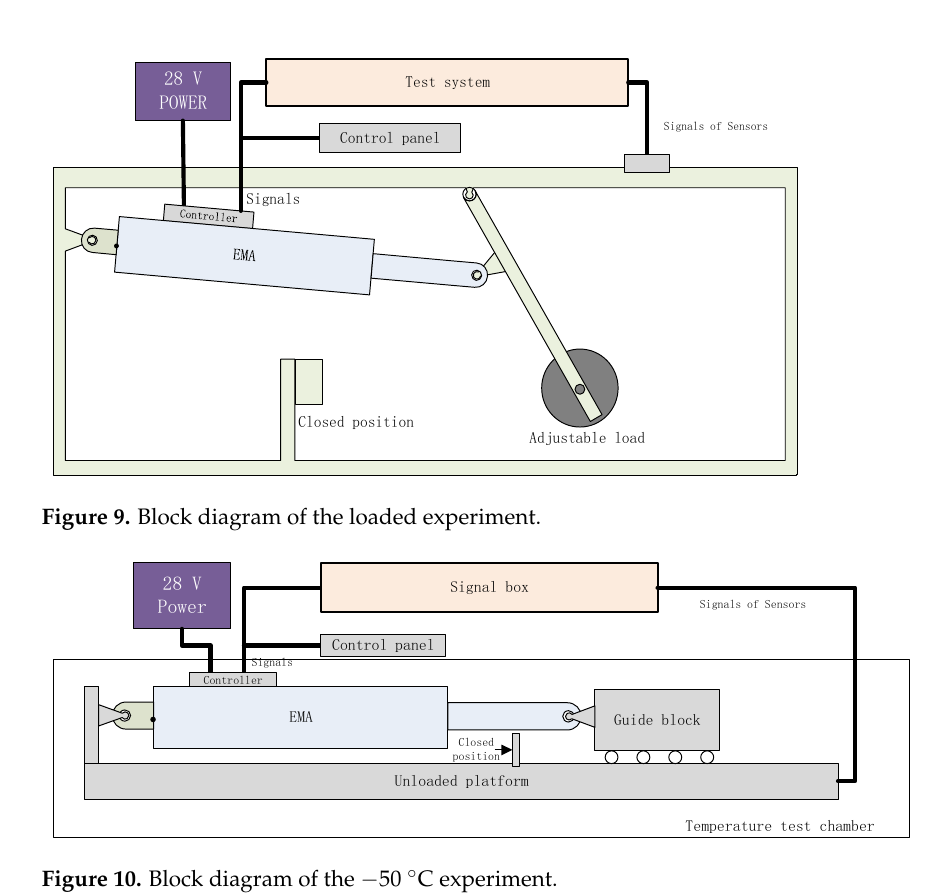
Figure 8. Simulation results of speed, 𝐼 (cid:3031)(cid:3030) , and 𝐼 (cid:3044)∗ . ( a ) Speed loop control when the load torque is 0.5 Nm and 1 Nm; ( b ) Hybrid control strategy when the load torque is 1 Nm.